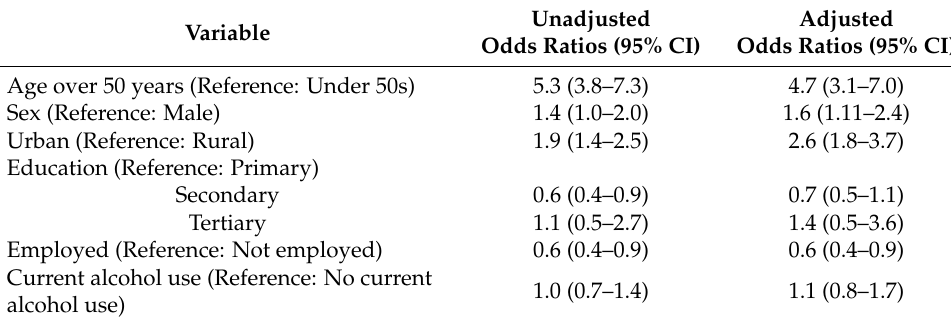
Table 3. Factors associated with having HIV